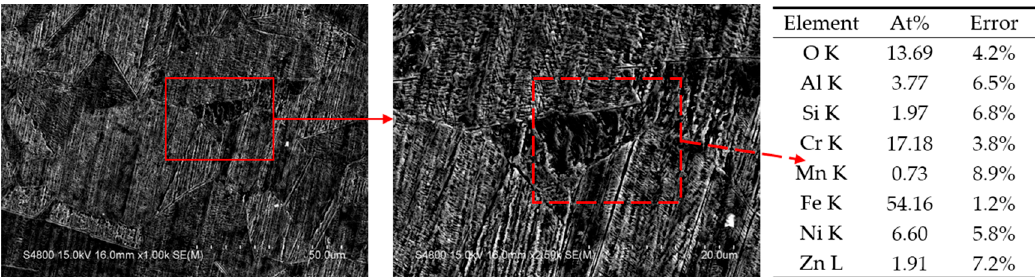
Figure 9. SEM images and the corresponding composition analysis of the passive film formed on 304L with the zinc treatment.